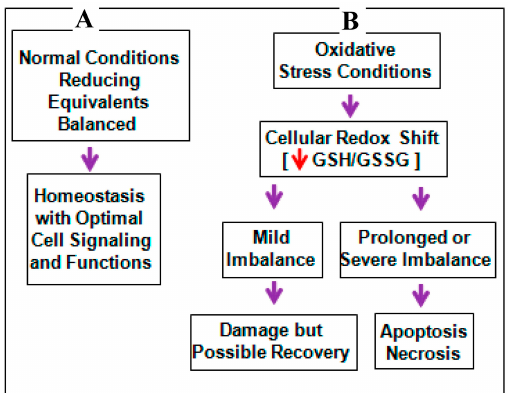
Figure 1. Under normal physiological conditions, redox homeostasis is maintained by a balance between the reactive oxygen species (ROS) and antioxidant components, mainly GSH/GSSG couple that acts as reducing equivalents leading to normal cellular signaling ( A ); when cells encounter mild stress, an imbalance in the redox shift marked by diminished GSH/GSSG ensues. Whilst, an appropriate management and/or interventions can normalize this shift and can rescue the cellular system against potential toxicity ( B ). However, during intense stress challenge, a toxic level of ROS can accumulate shifting the redox balance that cannot be reversed, leading to macromolecule damage ( B ). Red arrow indicates decrease in the levels and purple arrow indicates the flow of events.